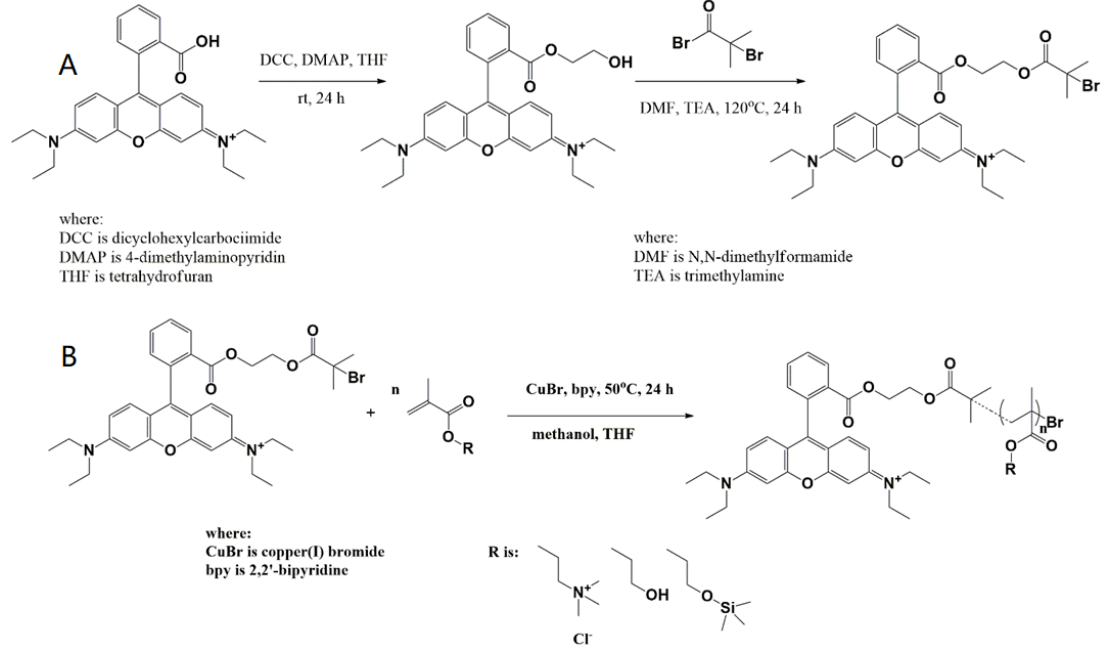
Figure 1. Synthesis of RhB fluorescent initiator ( A ) and its use in ATRP of methacrylates ( B ) .